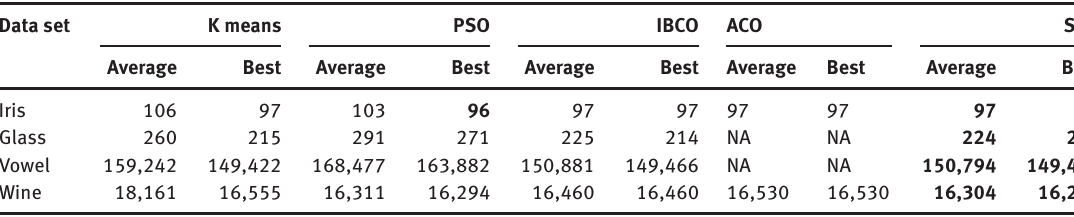
Table 7: SICD Comparison: Clustering Algorithms Data set K means